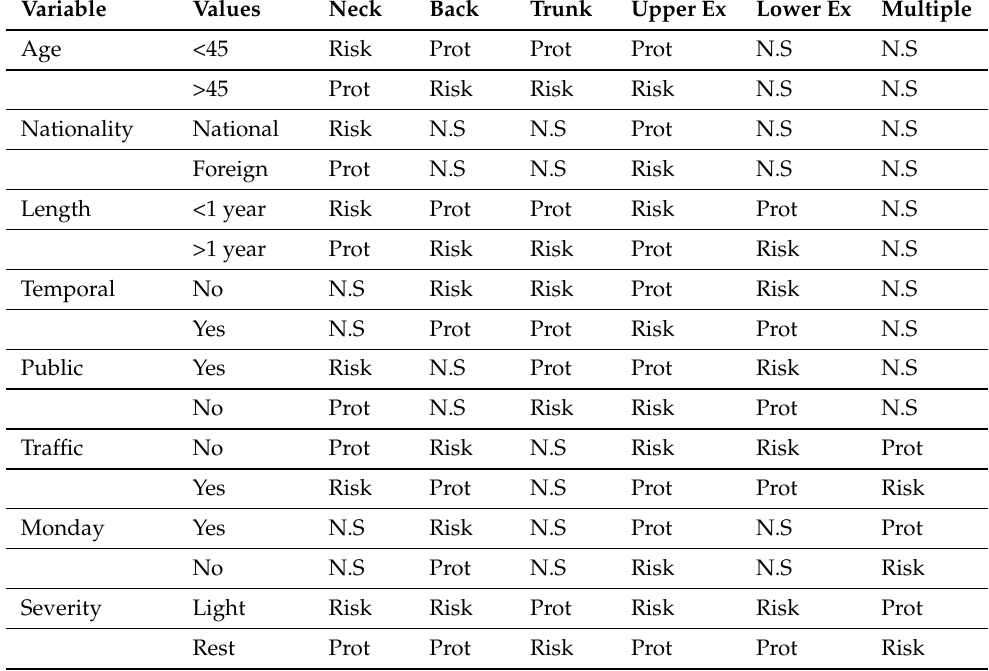
Table 2 summarized the protective effect of the variables analyzed. Table 2. Protective vs risk factors in injuries